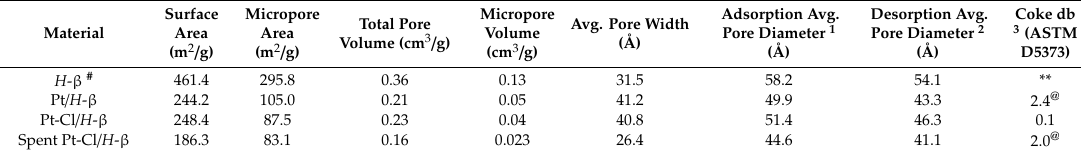
Table 2. Texture properties of zeolite molecular size and extruded catalyst determined by N 2 sorption using the BET